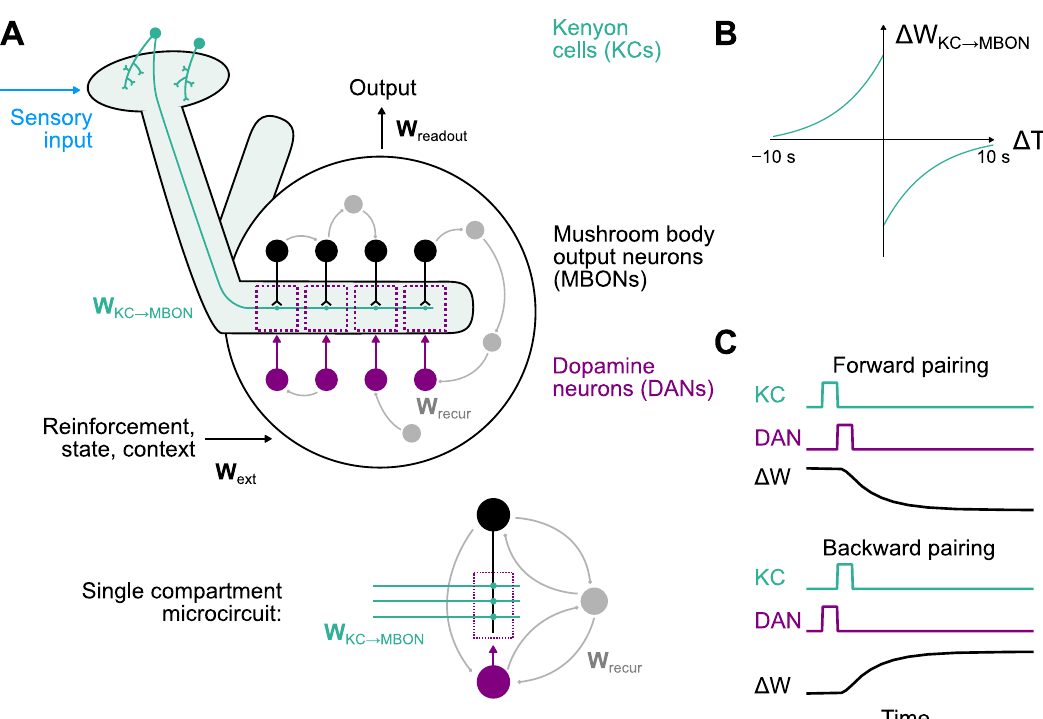
Fig 1. Diagram of the mushroom body model. (A) Kenyon cells (KCs) respond to stimuli and project to mushroom body output neurons (MBONs) via weights W KC ! MBON . These connections are dynamic variables that are modified according to a synaptic plasticity rule gated by dopamine neurons (DANs). Output neurons and dopamine neurons are organized into compartments (dotted rectangles). External signals convey, e.g., reward, punishment, or context to the mushroom body output circuitry according to weights W ext . A linear readout with weights W readout determines the behavioral output of the system. Connections among output neurons, dopamine neurons, and feedback neurons (gray) are determined by weights W recur . Inset: expanded diagram of connections in a single compartment. (B) The form of the dopamine neuron-gated synaptic plasticity rule operative at KC-to- MBON synapses. Δ T is the time difference between Kenyon cell activation and dopamine neuron activation. (C) Illustration of the change in KC-to-MBON synaptic weight Δ W following forward and backward pairings of Kenyon cell and dopamine neuron activity.